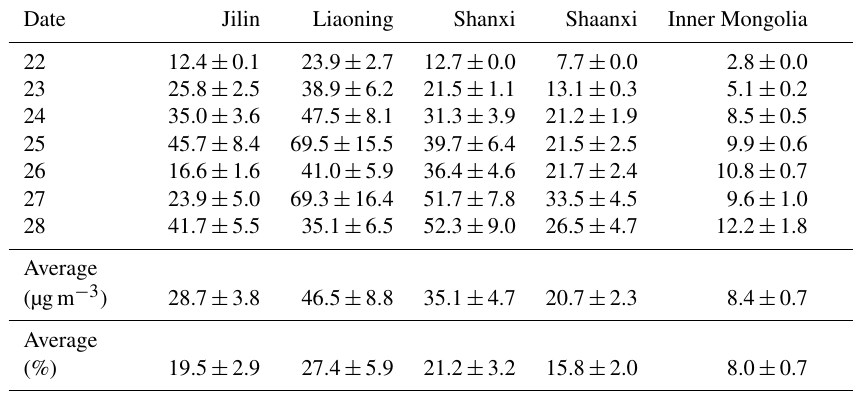
Table 3. Daily afternoon (12:00–18:00BJT) average O 3 contributions (µgm − 3 ) of NCP emissions in NEC and NWC from 22 to 28 May